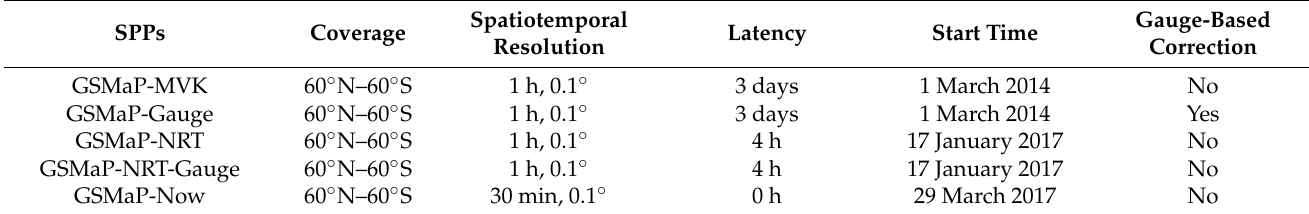
Table 1. Basic information of the GSMaP SPPs used in this